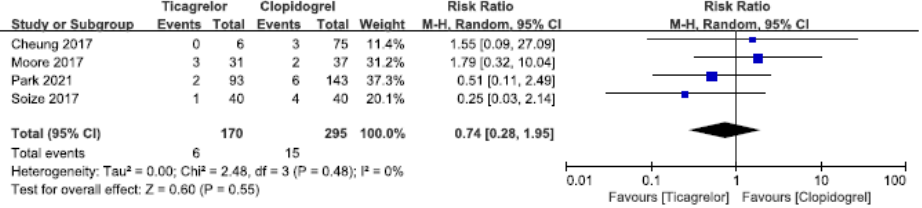
Figure 5. Forest plots of the meta-analysis comparing Neurologic disability between ticagrelor and clopidogrel treatment.